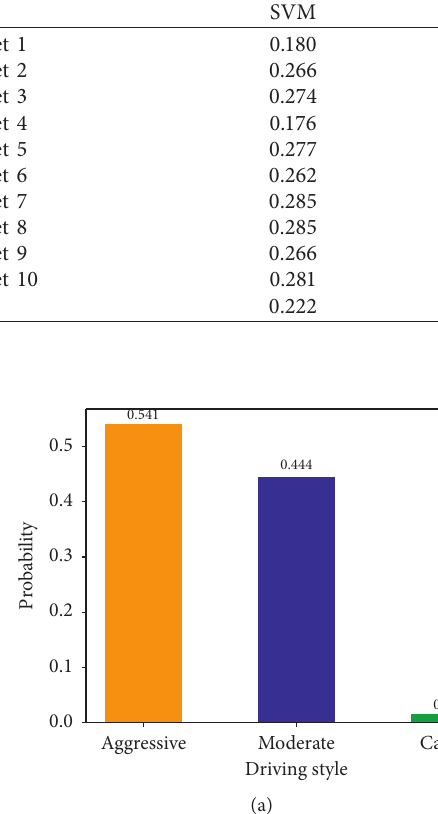
Figure 7: The example of the general distribution of driving styles for two drivers: (a) the distribution of driver 3 in test dataset 2; (b) the distribution of driver 8 in test dataset